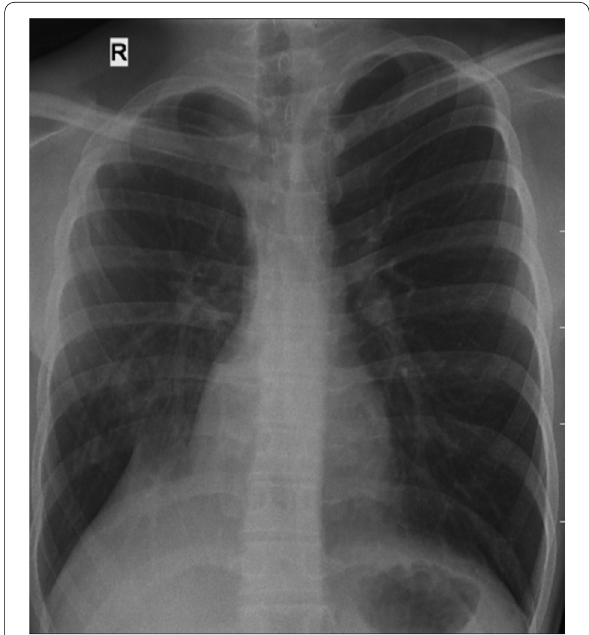
Fig. 1 Chest radiograph shows reduction of lung volume on the right side with mild ipsilateral mediastinal shift with an elevation of the right hemidiaphragm